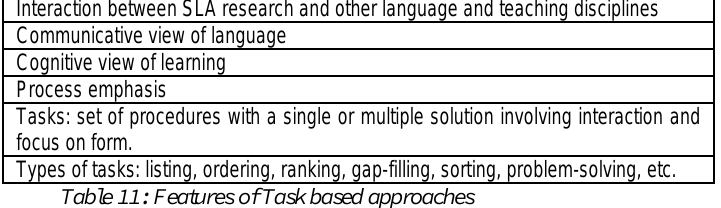
Table 11: Features of Task based